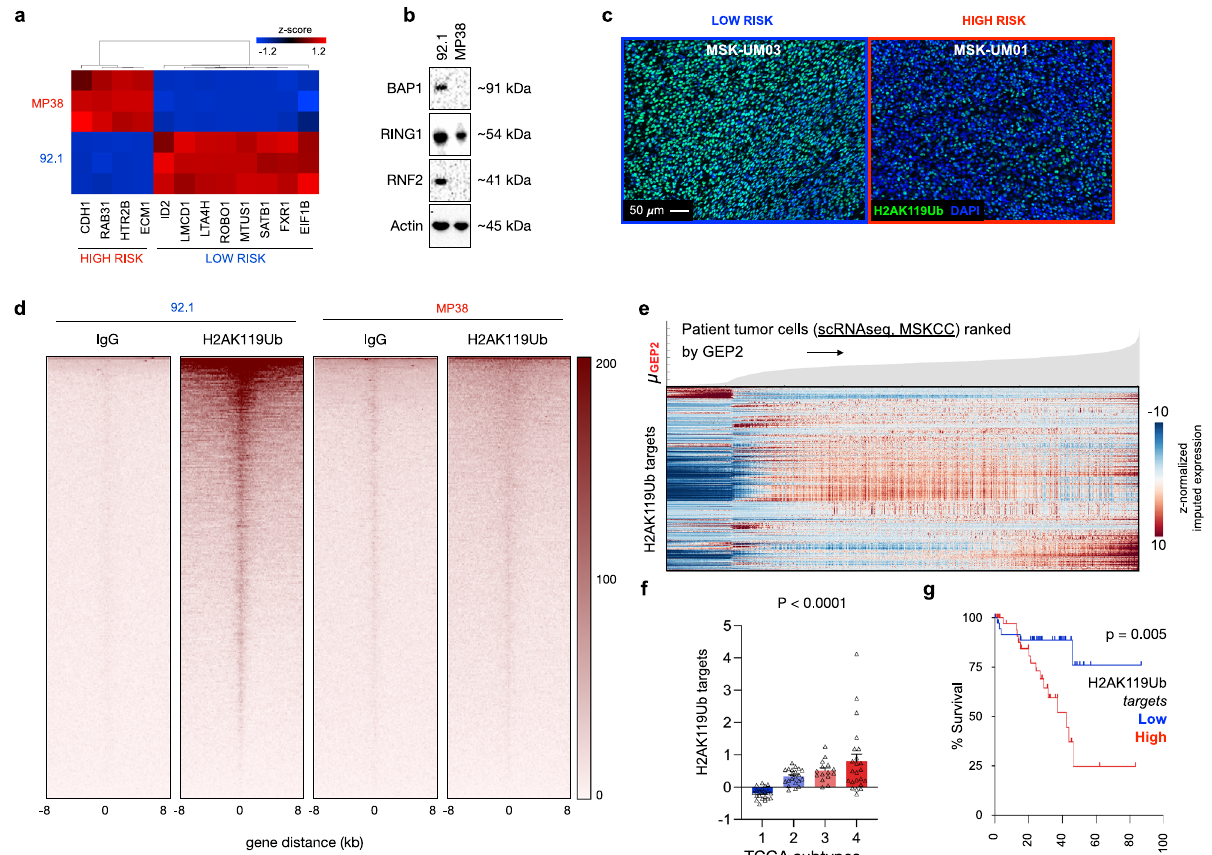
Fig. 2 Loss of PRC1-mediated transcriptional repression in high-risk UM. a Unbiased hierarchical clustering of UM cell lines, 92.1 and MP38, in biological triplicates, based on normalized FPKM values of the GEP 12-discriminant geneset 19 . b Western blot of BAP1 and PRC1 core ligases RING1 and RNF2 relative to actin in 92.1 and MP38 cells. Data representative of biological triplicates. c Immuno fl uorescence of ubiquitinated H2A (green) and DAPI (blue) in MSK- UM03 (greatest proportion of GEP1 tumor cells in the cohort) and MSK-UM01 (greatest proportion of GEP2 tumor cells in the cohort). Representative images from six biological specimens. d Heatmaps representing CUT&RUN intensities of H2AK119Ub normalized to IgG in 92.1 and MP38. Data representative of biological duplicates. e Expression of H2AK119Ub target genes for individual tumor cells ranked by average imputed expression of the GEP2 gene signature (gene signatures annotated in Supplementary Data File 1) in ascending order from left to right. For each gene, imputed expression was z-normalized across all cells and smoothed using a 20-cell moving average window. Top, fi lled area plot showing average expression of GEP2 signature genes across ranked tumor cells. f Expression of H2AK119Ub target genes across the 4 molecular TCGA subtypes. Statistical signi fi cance tested using one- way ANOVA; p = 7.3 × 10 − 6 ; n = 80. Bars, mean of average expression; error bars, standard error of the mean. g Overall survival of ( n = 80) TCGA-UM patients with primary tumors strati fi ed by high (top 50th percentile, n = 40) and low (bottom 50th percentile, n = 40) expression of the ‘ H2AK119Ub targets ’ geneset. Statistical signi fi cance tested using two-sided log-rank